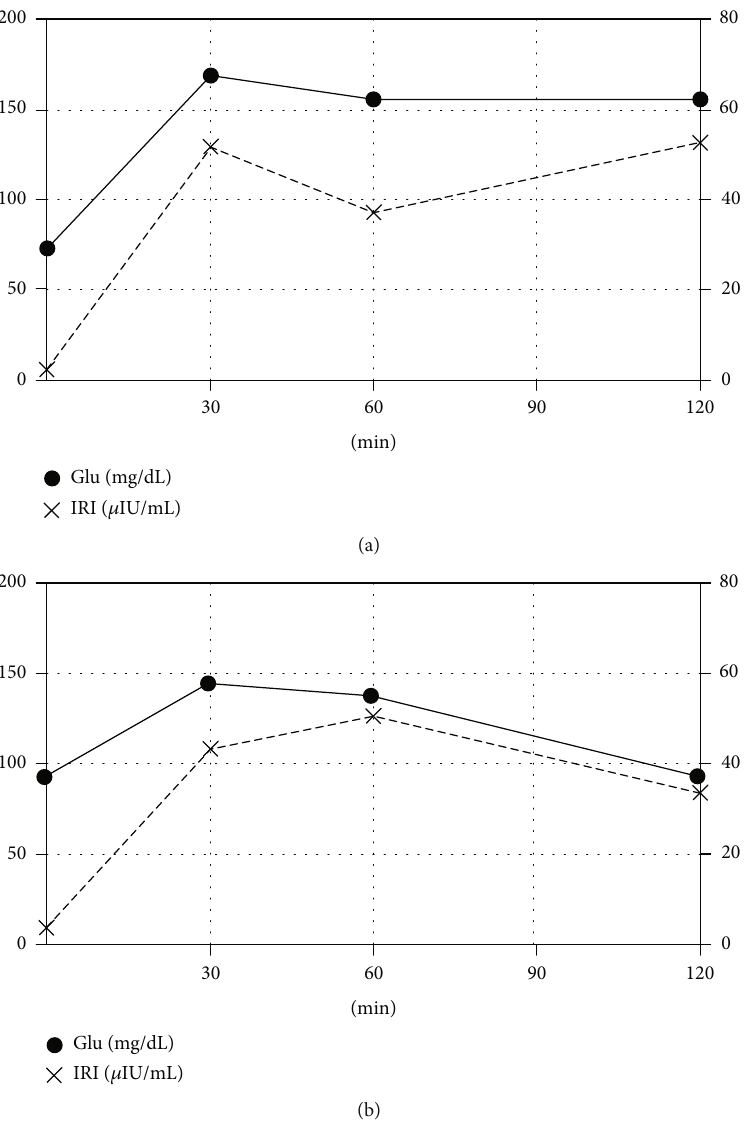
Figure 6: Results of the 75g oral glucose tolerance test. (a) Two days postpartum: HOMA − R = 0 : 47 , QUICKI = 0 : 44 , MI = 9 : 38 , DI = 4 : 81 , and II = 0 : 51 . (b) Seventeen weeks postpartum: HOMA − R = 0 : 82 , QUICKI = 0 : 40 , MI = 8 : 02 , DI = 6 : 08 , and II = 0 : 76 . HOMA-R: homeostasis model assessment insulin resistance; QUICKI: quantitative insulin-sensitivity check index; MI: Matsuda index; DI: disposition index; II: insulinogenic index.